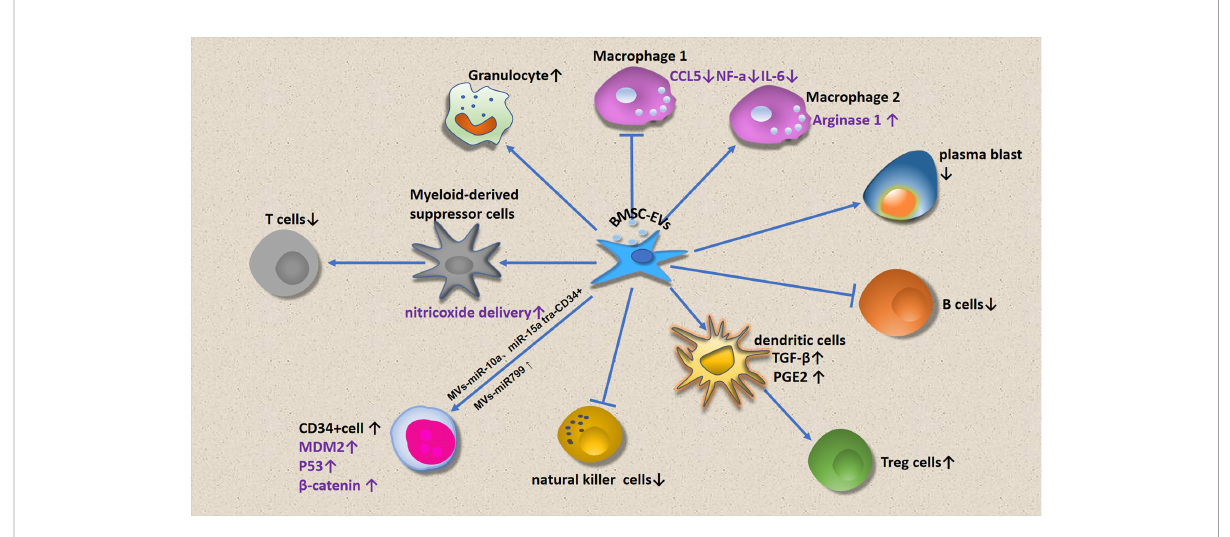
FIGURE 2 Effects of BMSC-EVS on BM microenviromental